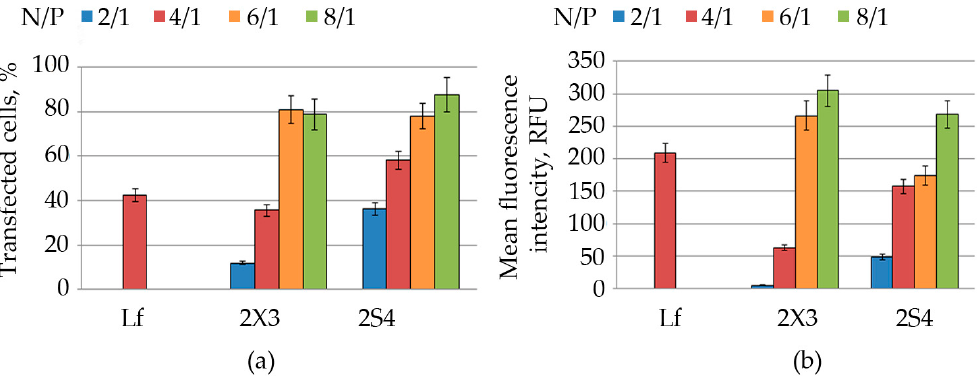
Figure 2. Transfection efficacy of CL/pEGFP-C2 complexes formed at different N/P ratios: ( a ) Percentage of transfected cells; ( b ) Mean fluorescence intensity of the cell population. Lf (Lipofectamine ® 2000) and 2X3 cationic liposomes (CLs) were used as positive control. Experiments were performed in the presence of 10% FBS, each in triplicate. Standard deviation did not exceed 7–9%. From the physicochemical point of view, the differences between the 2X3 and 2S4 CLs may be explained by the fact that CL/pEGFP-C2 complexes of 2S4 were larger (250 nm versus 120 nm) and more heterogeneous (PIs 0.369 and 0.143, respectively) as compared with CL/pEGFP-C2 complexes of 2X3 at N/P ratio of